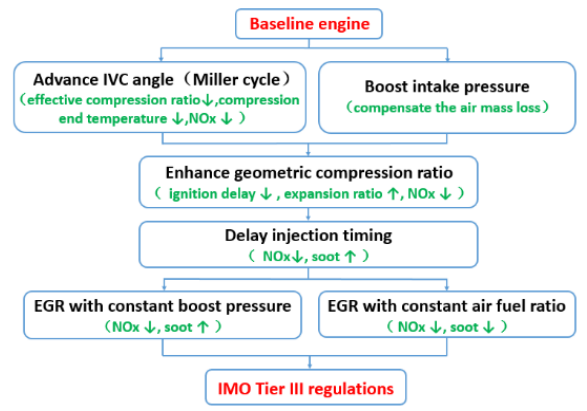
Figure 2. IMO Tier III technology